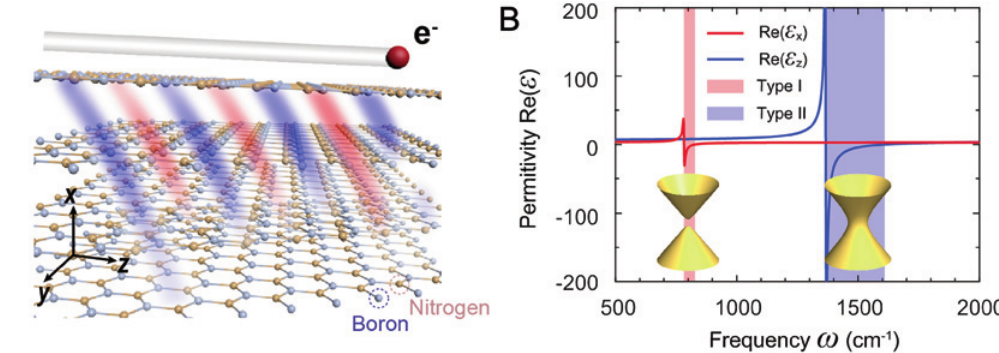
Figure1: (A)SchematicofvolumeCherenkovradiation(CR)generationinhBNusinganelectronbunch;(B)RealpartofhBNpermittivitywithin frequencyrange ω =500 – 2000cm − 1 .Shadedareasreferto type-Iandtype-IIhyperbolicregions.Insetsdemonstrateiso-frequencysurfacesat ω = 800 cm − 1 and ω = 1500 cm − 1 .